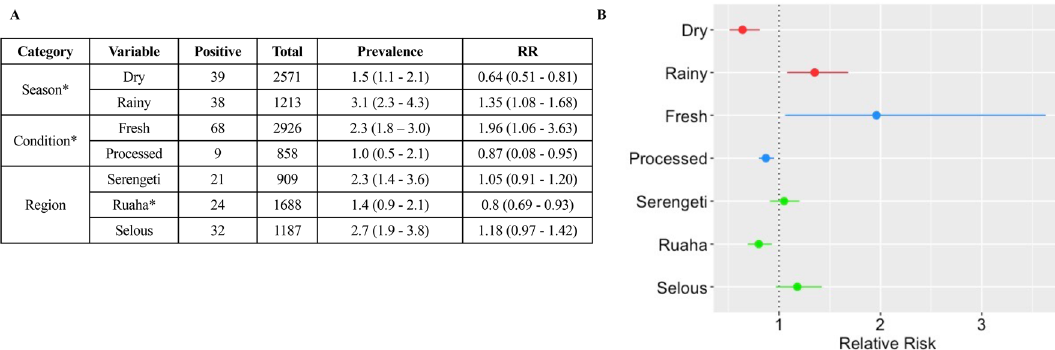
Figure 3. Relative risk (RR) of the positive bushmeat samples associated with different variables. ( A ) Counts (positive and total samples), prevalence and RR associated with each variable. The 95% confidence intervals are reported in parethesis. ( B ) Graph of the RR for each variable. The relative risk (pointS) and 95% confidence interval (lines) for each variable are reported for the seasonal data (red), sample condition (blue) and regions (green). Results indicate that there is a 71% higher risk of a sample collected from rainy season being positive than samples collected during dry season. There is a 109% higher risk of a fresh sample being positive than processed sample. There is also a 64% lower risk of a sample collected from Ruaha being positive that the other regions (the RR of samples collected from both Selous and Serengeti is 1.44). Significant differences in RR analysis are reported (* p <